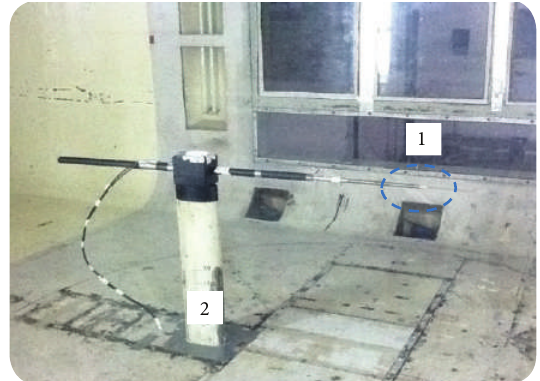
Figure 6. Hot wire probe in the middle of test section – (1) Hot wire probe; (2)